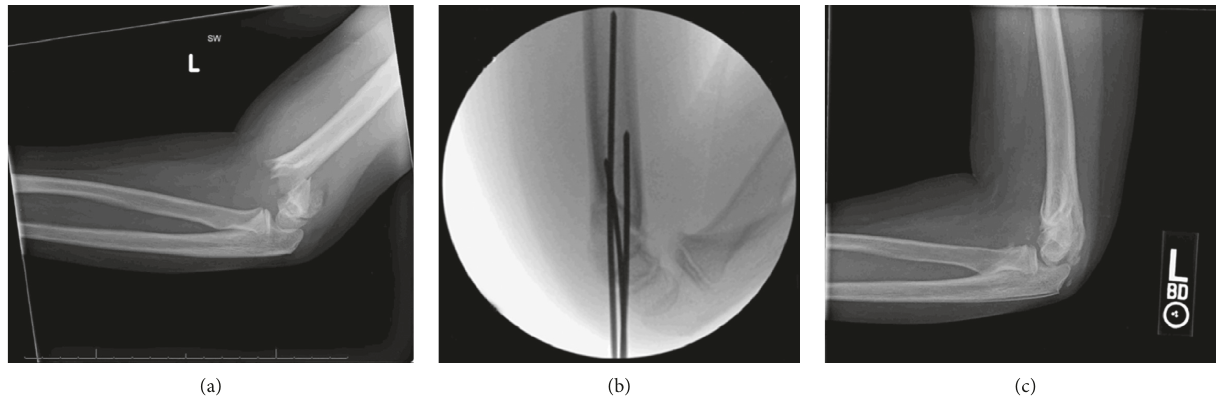
Figure 1: Plain films of the left elbow immediately after injury in the emergency department (a), intraoperative fluoroscopic film showing reduction and pin placement (b), and follow-up plain film imaging at 12 weeks after surgery